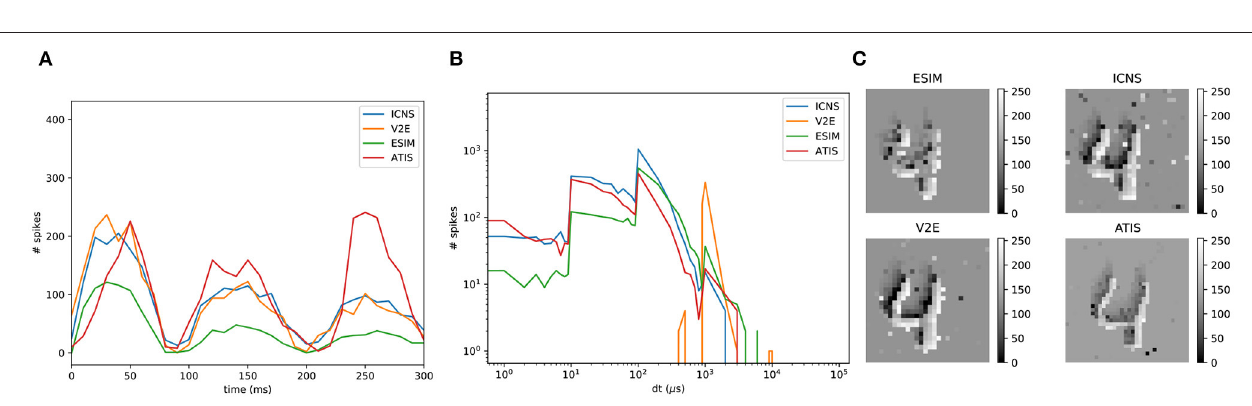
every digit in the MNIST database requires the same saccadic pattern to be identified is an assumption commonly made but conflicting with physiological studies (Rayner, 1998). As the